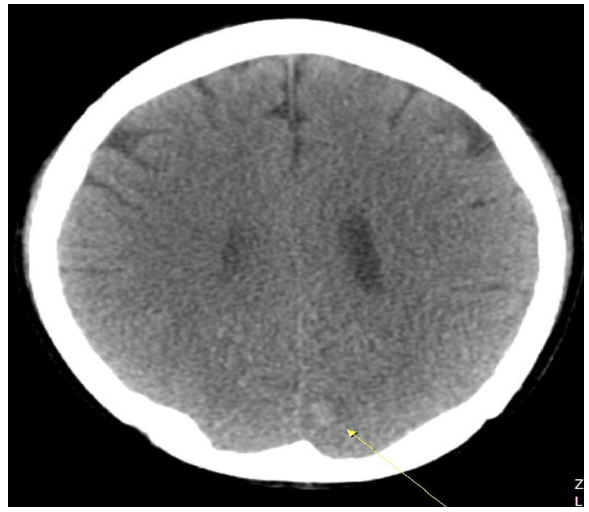
Figure 3. Brain CT scan showing intracranial hemorrhage three days after admission.